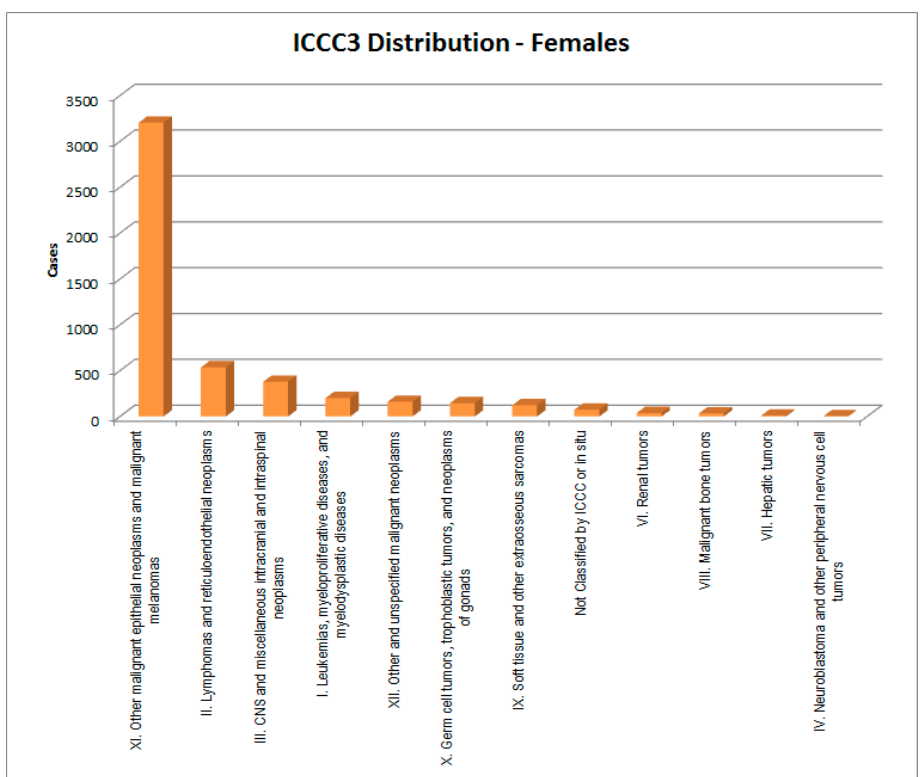
Figure 3. ICCC3 (standard) distribution of cases—females.